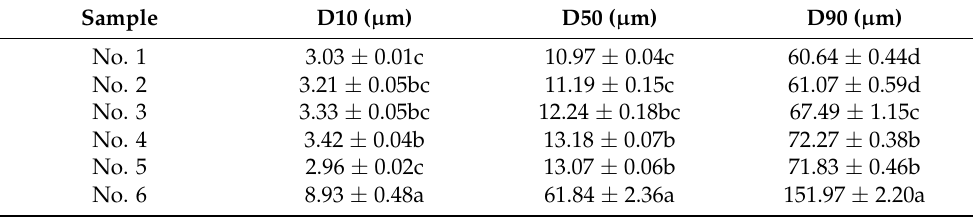
Table 1. Particle size distribution of Tartary buckwheat flour with different particle size 1 .